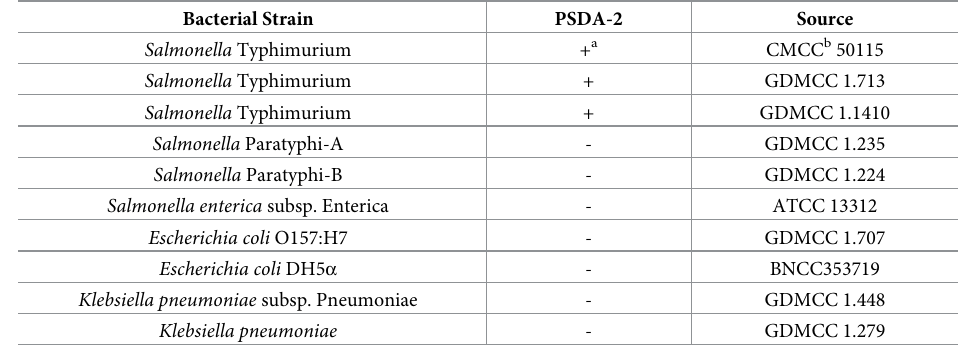
a +, indicates cleavage; − , indicates no cleavage. b CMCC, China Center for Medical Culture Collection; GDMCC, Guangdong Microbial Culture Collection Center; BNCC, BeNa Culture Collection; ATCC, American Type Culture